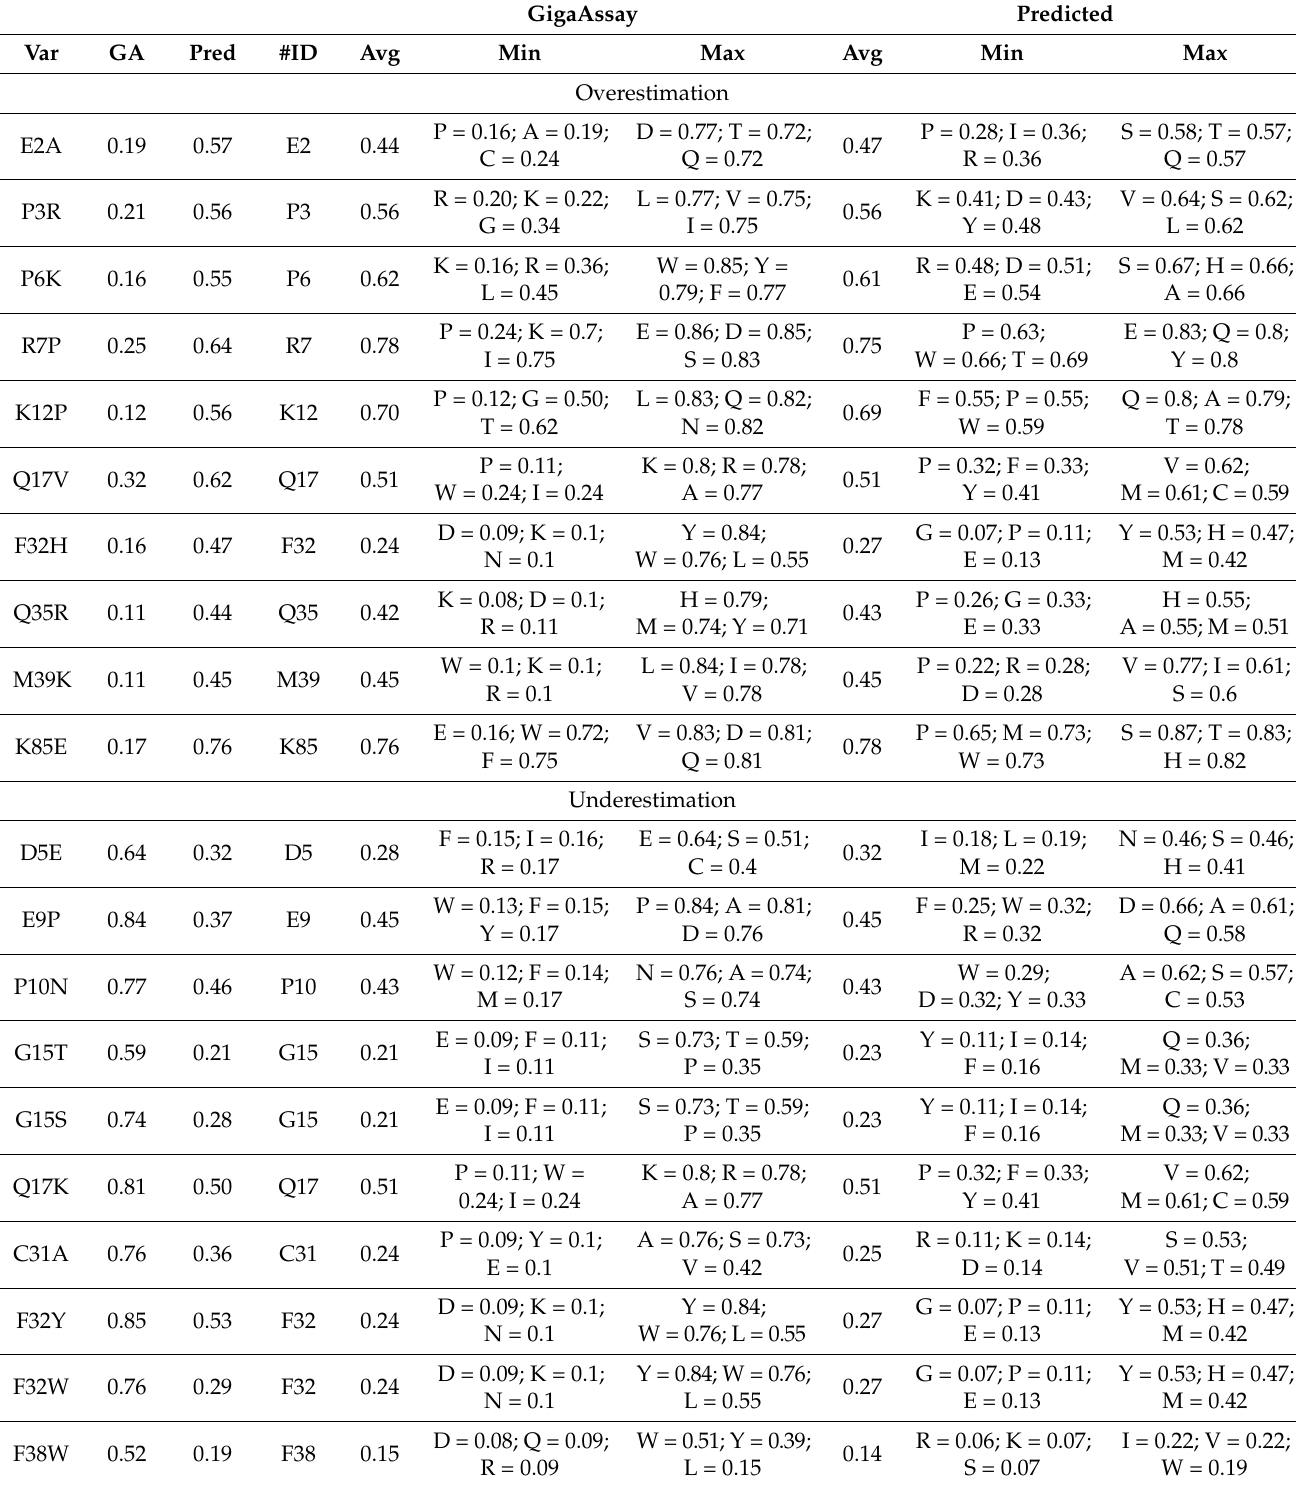
Table 2. Overestimated and underestimated outliers predicted by